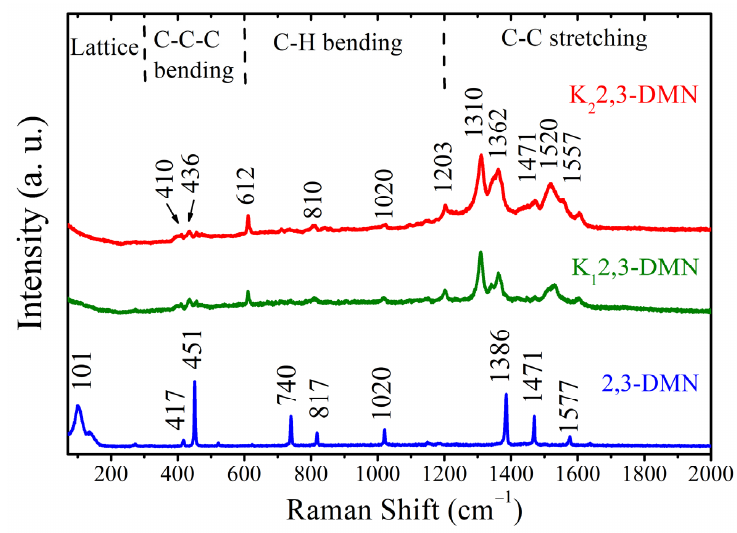
Figure 3. Raman scattering spectra of pristine and potassium-doped 2,3-DMN.